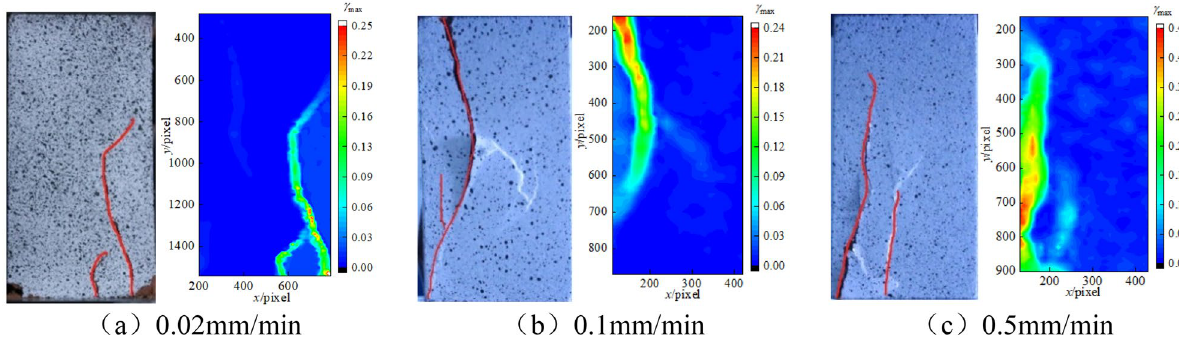
Figure 10. Peak deformation field and final failure form of specimens under three loading